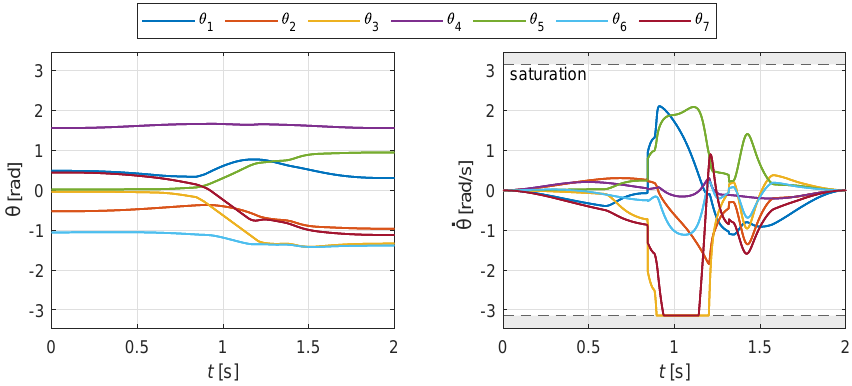
Figure 17. Example 3: joint rotations and speeds for the motion shown in Figure